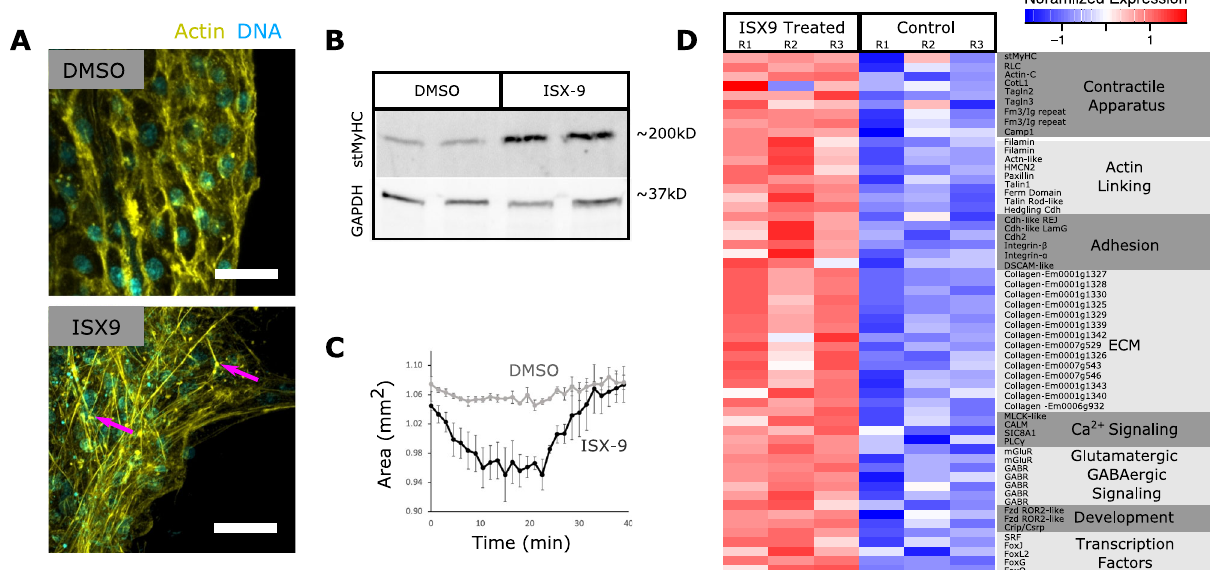
Fig. 6 MRTF drives contractile tissue differentiation in primmorphs. A Primmorphs treated with 50 µ M ISX or DMSO and stained with phalloidin (yellow) and Hoechst (cyan). B Western Blot showing elevated stMyHC levels in ISX-treated samples. Raw and uncropped scans in source data fi le. C Contraction dynamics of ISX-treated primmorphs in response to thapsigargin. Data are presented as mean values + / − SEM. ( n = 3 biological replicates). D Heatmap of select transcripts that were differentially expressed in ISX-treated samples. Primmorphs treated with ISX and vehicle controls were maintained in an attachment-free environment in nine independent experiments. Phalloidin stainings were performed twice, total protein extraction was performed on one sample, and total RNA was extracted from three independent experiments with consistent results. Scale bars 10 μ